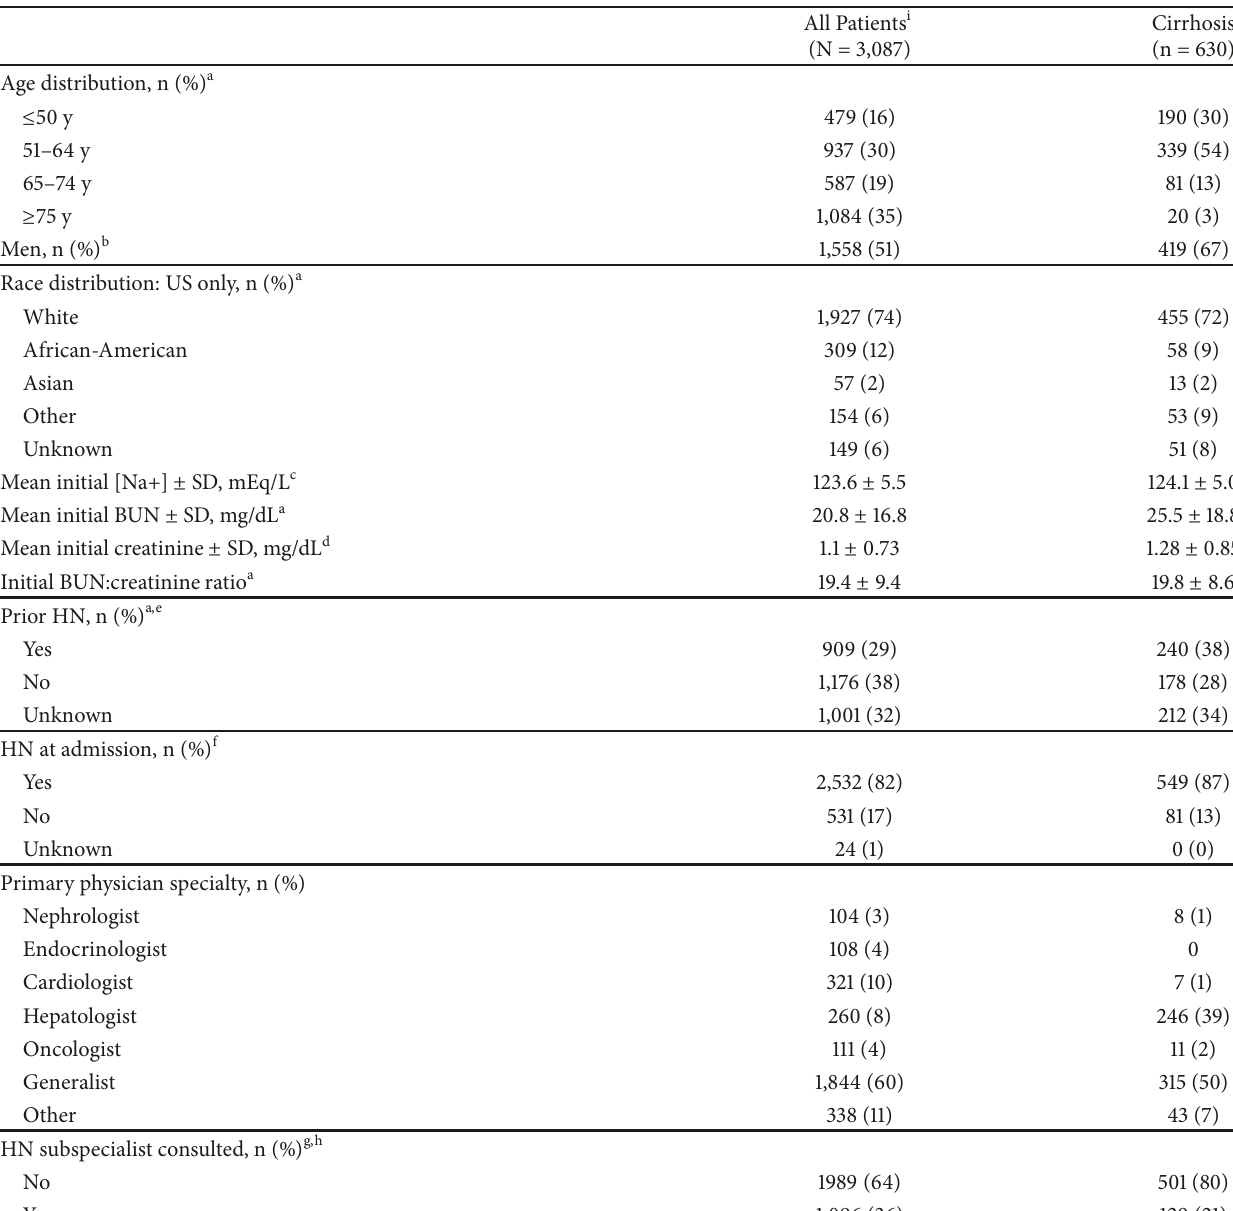
Table 1: Baseline demographic